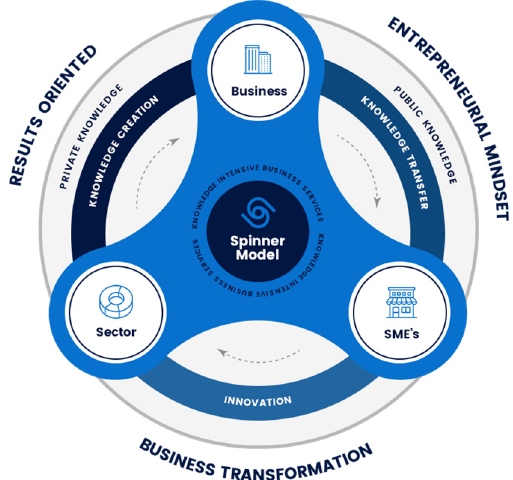
Figure 1. The Spinner model, Figueiredo and Ferreira (Figueiredo et al.